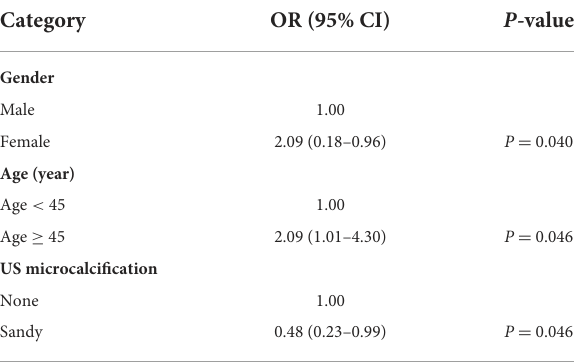
TABLE 3 Statistical data of the logistics regression